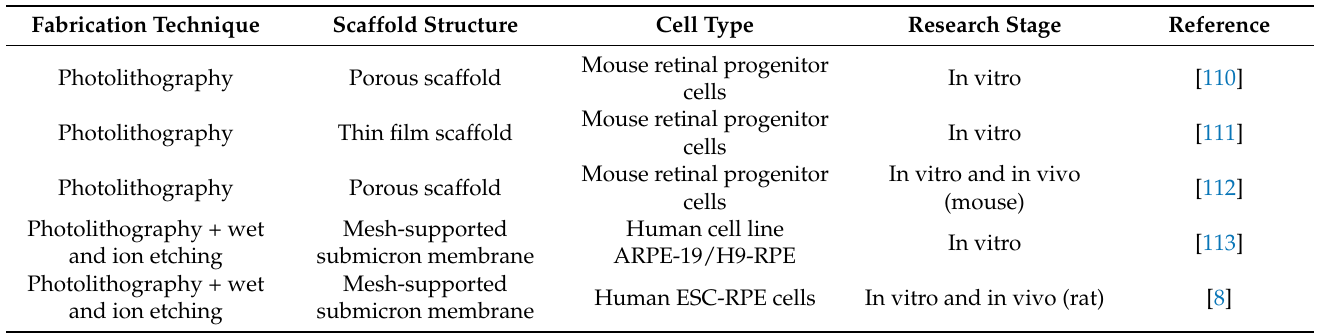
Table 3. A summary of retinal scaffolds fabricated by lithography techniques. This table highlights the fabrication technique, the structure of scaffold and the cell type used. RPE: retinal pigment epithelium; ESC: embryonic stem